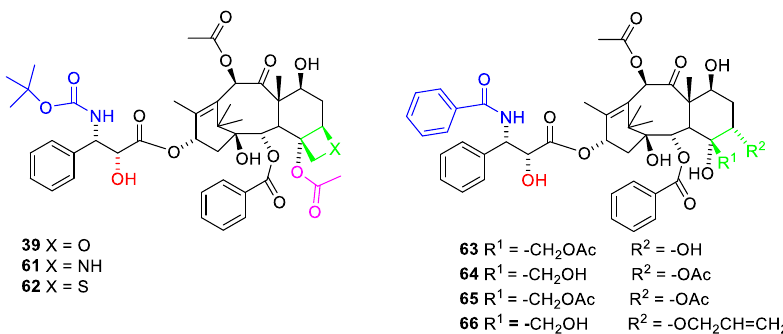
Figure 18. Docetaxel ( 39 ) analogues in which the oxetane oxygen has been replaced with nitrogen ( 61 ) of sulfur ( 62 ) [69]. Paclitaxel analogues in which the oxetane ring (green) has been opened ( 63 – 66) [65,72]. The 4-acetoxy group is magenta.